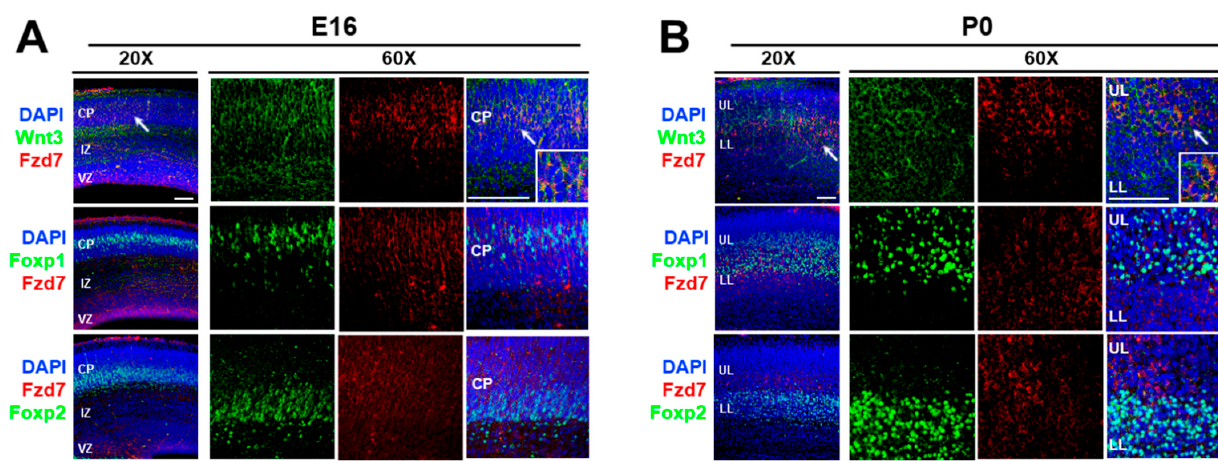
Figure 2. Colocalization of Wnt3 and Fzd7 with Foxp1 and Foxp2 expression at E16 and P0. ( A , B ). Immunohistochemistry (IHC) for Wnt3 (green), Fzd7 (red), Foxp1 (green), and Foxp2 (green) in WT E16 ( A ) and P0 ( B ) neocortices ( n = 5 animals per age). Arrow denotes colocalized area between Wnt3 and Fzd7 in confocal microscope image using 20× objective lens, which was confirmed with 60× resolution (insert: higher magnification image of colocalization). DAPI shown in blue; CP: cortical plate; IZ: intermediate zone; VZ: ventricular zone; UL: upper layers; LL: lower layers; scale bar: 100 µm.